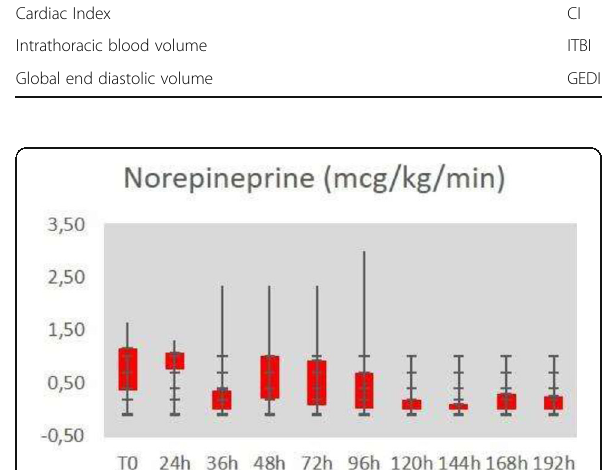
Fig. 1 (abstract 0301). See text for description